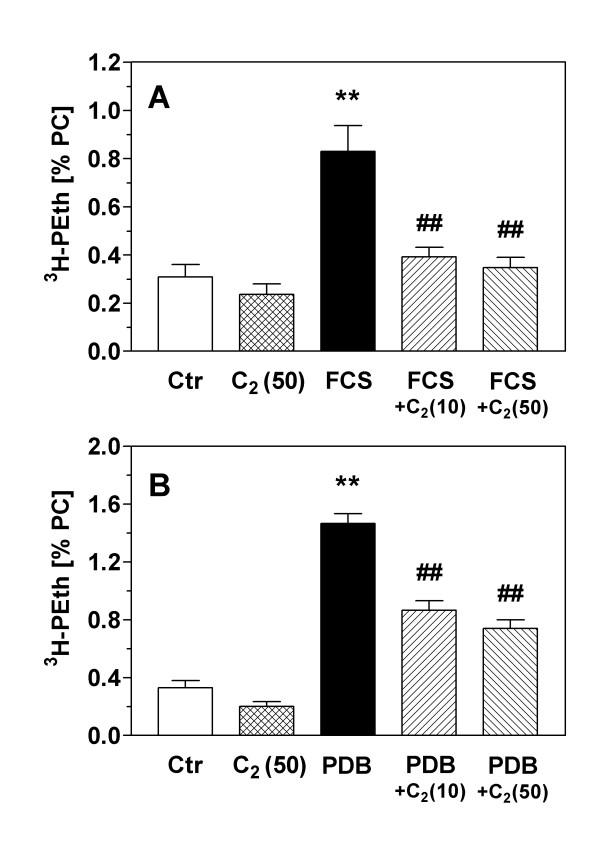
Inhibition of phospholipase D activity by ceramide. PLD activity in serum-starved, [3H]-glycerol-labeled astrocytes was determined by the transphosphatidylation assay; in the presence of ethanol, PLD converts [3H]-phosphatidylcholine (PC) into [3H]-phosphatidylethanol (PEth) which reflects PLD activity. In (A), PLD activity was stimulated by addition of medium containing 10% fetal calf serum (FCS) for 5 min. In (B), PLD activity was stimulated by 4β-phorbol-12β,13α-dibutyrate (PDB; 1 μM) for 30 min. C2-ceramide ("C2") was added to the cultures in concentrations of 10 and 50 μM 45 min before the addition of FCS and PDB, respectively. Data are means ± S.E.M. of 7–8 experiments and are expressed as [%] PEth/PC. Statistics: ANOVA, (A) F4,36 = 14.0, p < 0.0001; (B) F4,37 = 75.2, p < 0.0001. **, p < 0.01 vs. controls. ##, p < 0.01 vs. stimulated PLD activity (Tukey-Kramer multiple comparisons test).